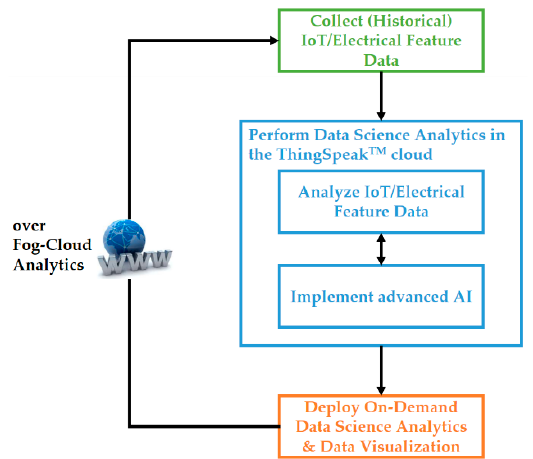
Figure 5. Workflow of the open and powerful cloud analytics platform, ThingSpeak ™ with MATLAB ® analytics, configured over fog-cloud analytics for DSM in this study.